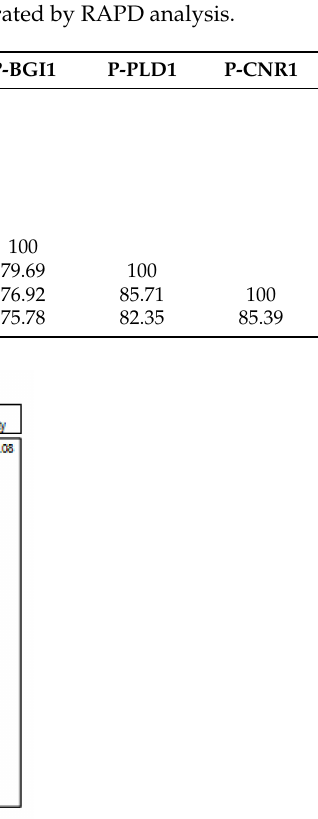
Figure 6. Non-metric MDS analysis of E. pisi isolates based on RAPD primers.